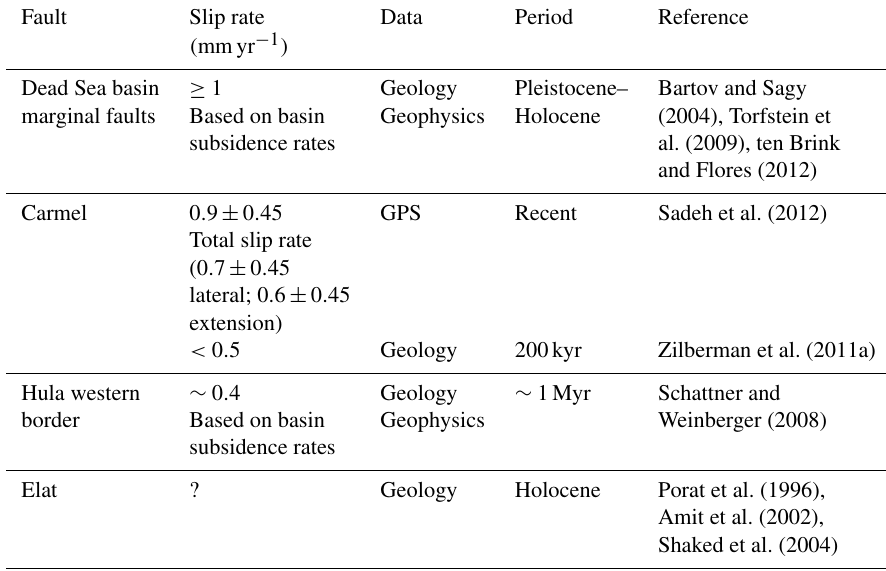
Table 2. Marginal faults and branches with integrated slip or subsidence of ~0.5–1mmyr and